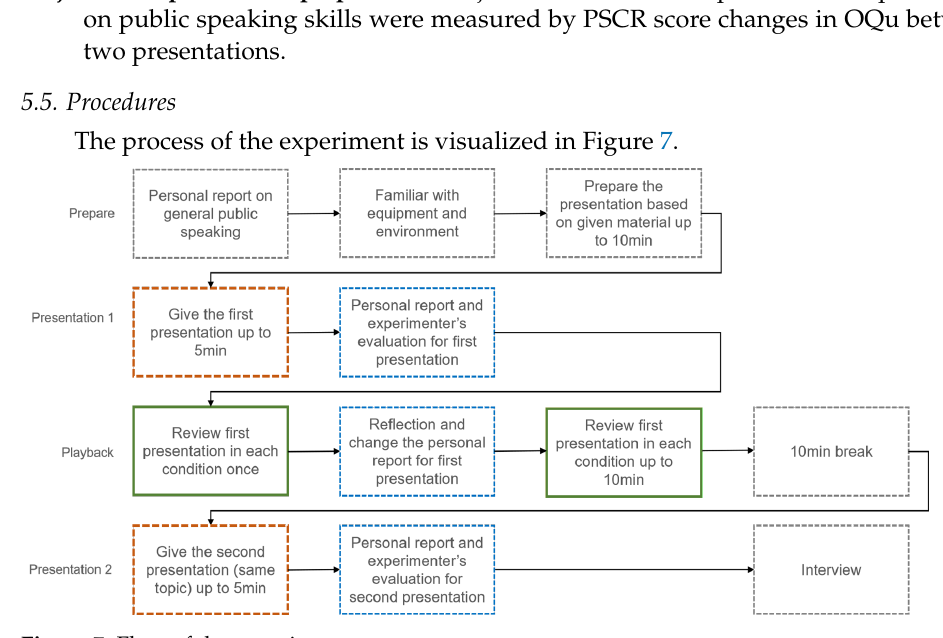
Figure 7. Flow of the